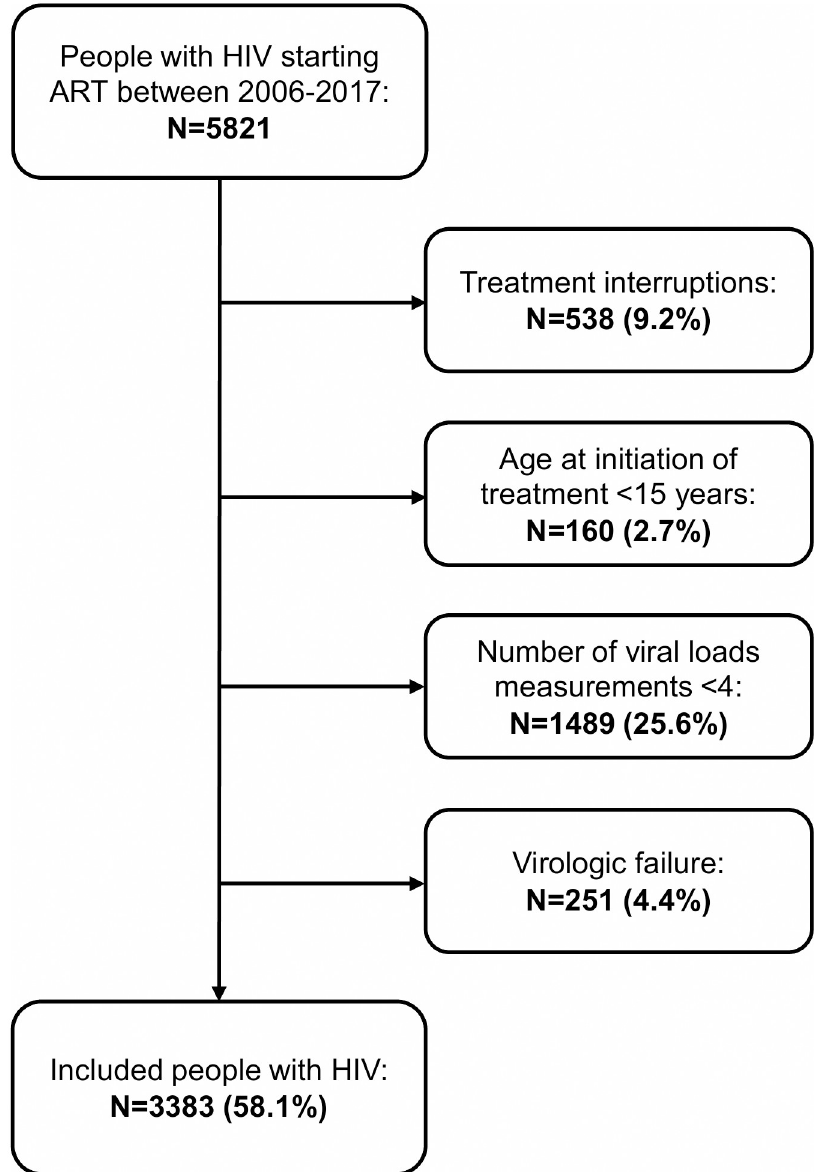
Fig 1. Flow chart of study inclusion and exclusion. Abbreviation: ART, antiretroviral